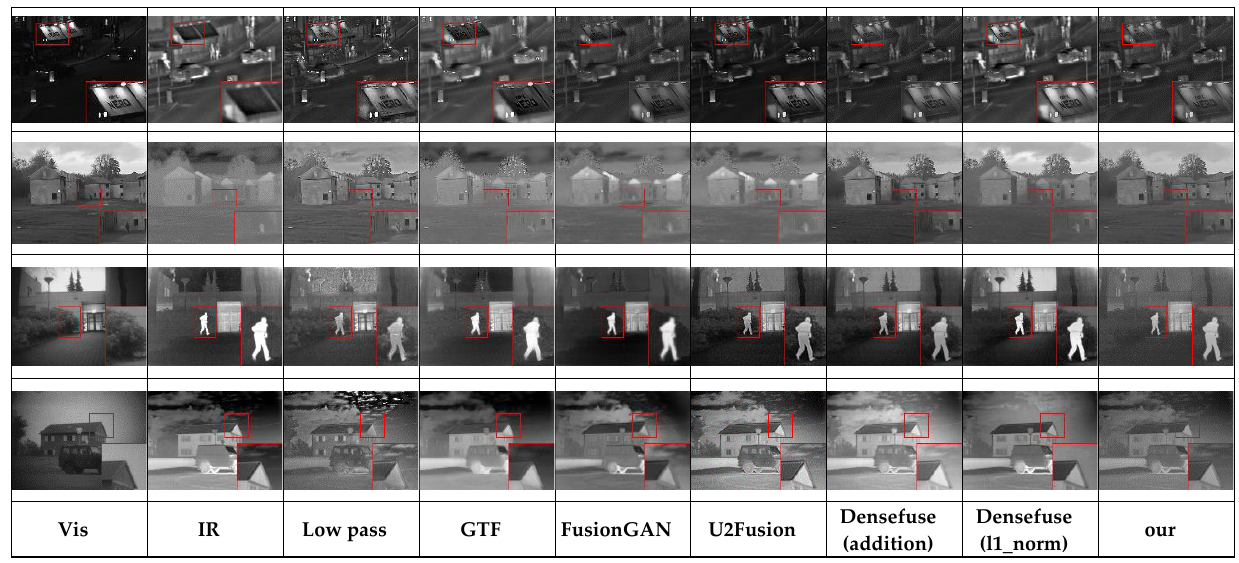
Figure 7. Qualitative comparison of our method with 5 state-of-the-art methods on 4 typical VIS and IR image pairs in the TNO dataset. For a clear comparison, we use a red box to select a small area in each image and zoom in it in the bottom right corner.